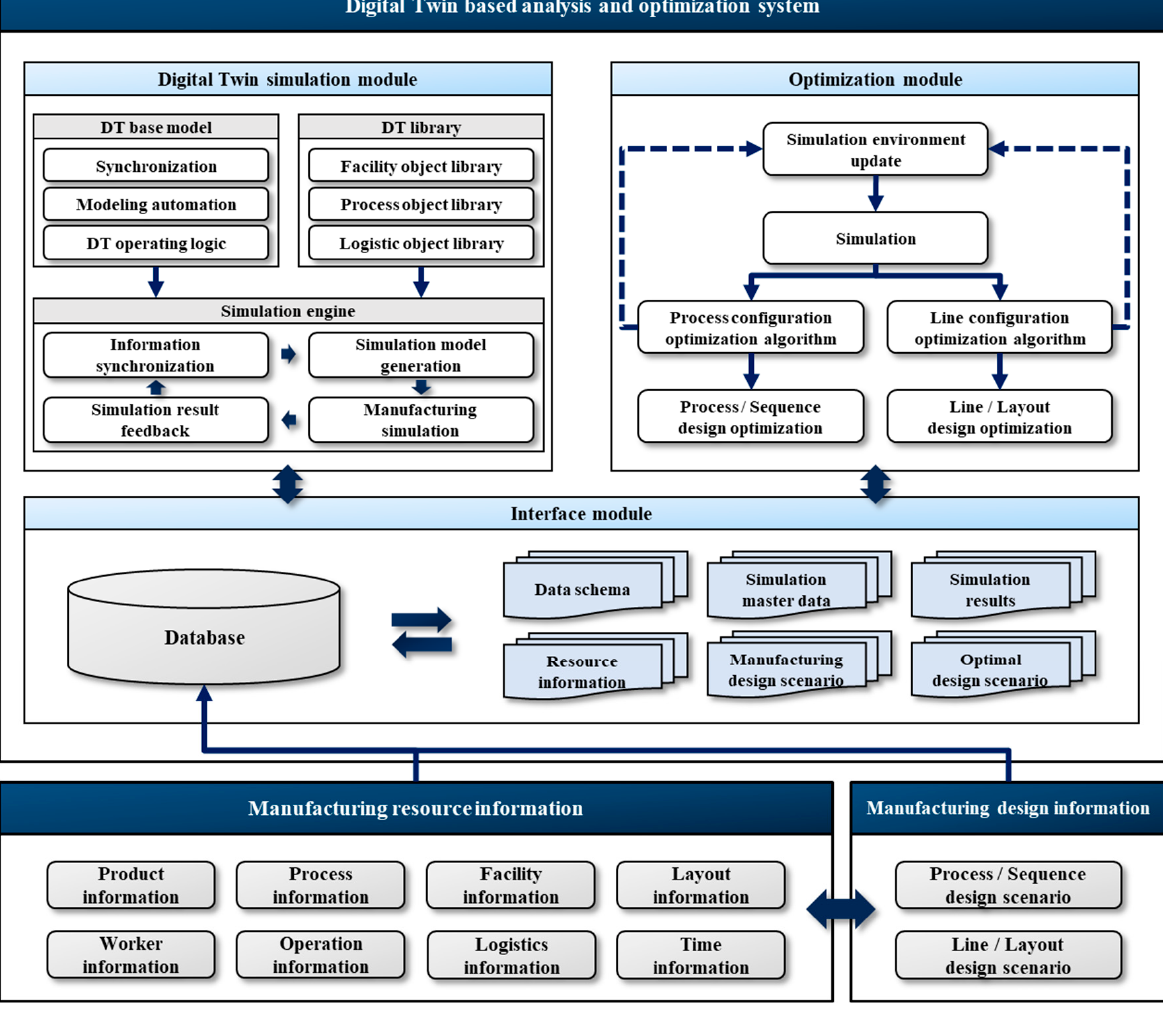
Figure 1. Framework for the DT-based analysis and optimization system.